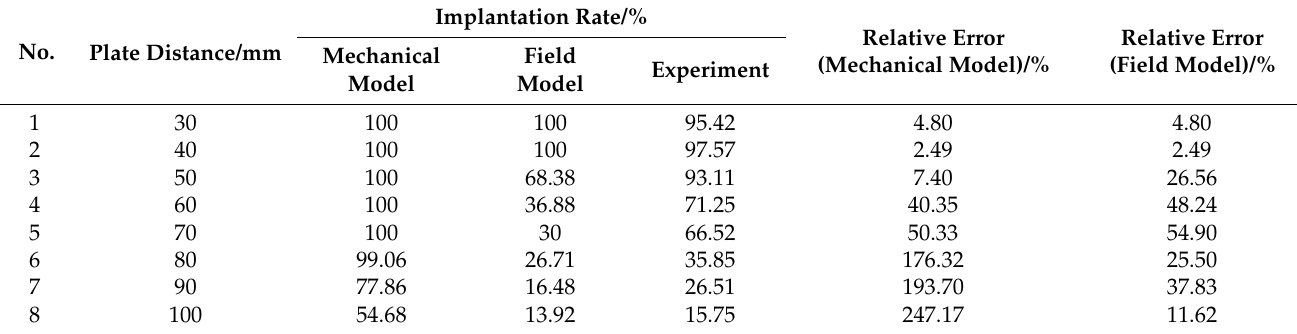
Table 5. Results for different pole plate spacing.